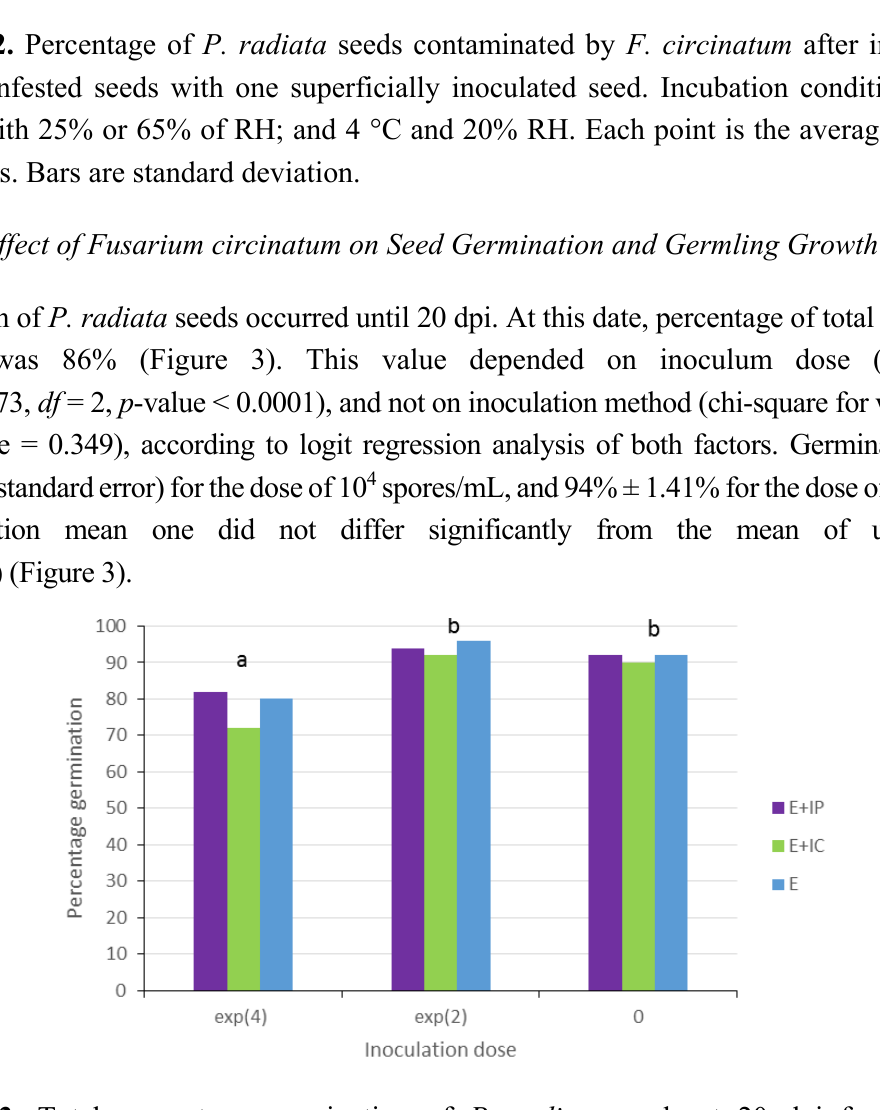
Figure 3. Total percentage germination of P. radiata seeds at 20 dpi for different inoculation doses and inoculation method: exp (4) = 10 4 spores/mL; exp (2) = 10 2 spores/mL; E + IP = internal by immersion of pre-germinated seeds; E + IC = internal by immersion of seeds previously rubbed with carborundum: E = external by immersion. Treatments with different letters differ significantly at P = 0.05. No significant differences were among inoculation